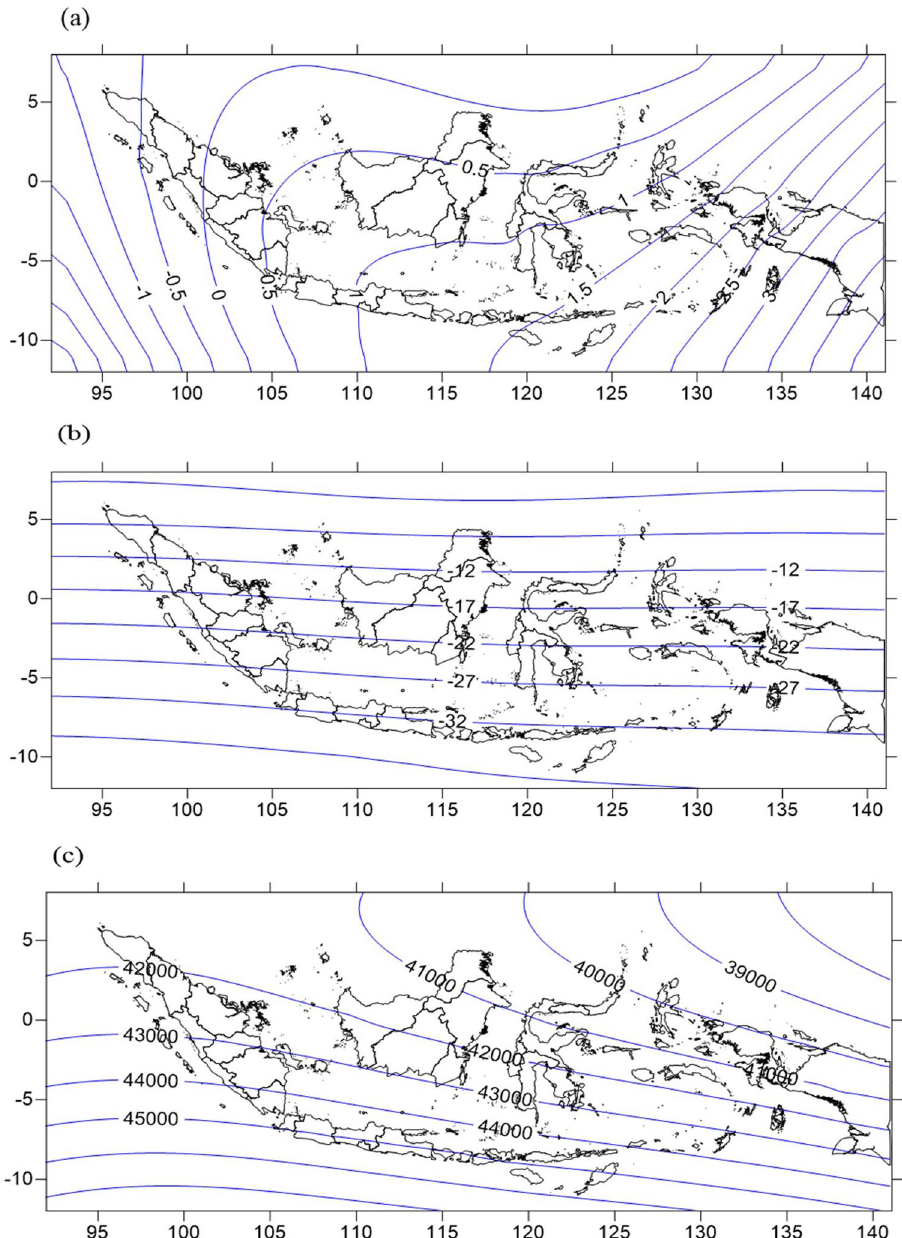
Figure 4. Geomagnetic chart for epoch 2015.0 using the collocated cokriging method in Indonesia; ( a ) Declination Comp. with Δ = 0.5°, ( b ) Inclination Comp. with Δ = 5°, and ( c ) Total Intensity Comp. with Δ = 1000